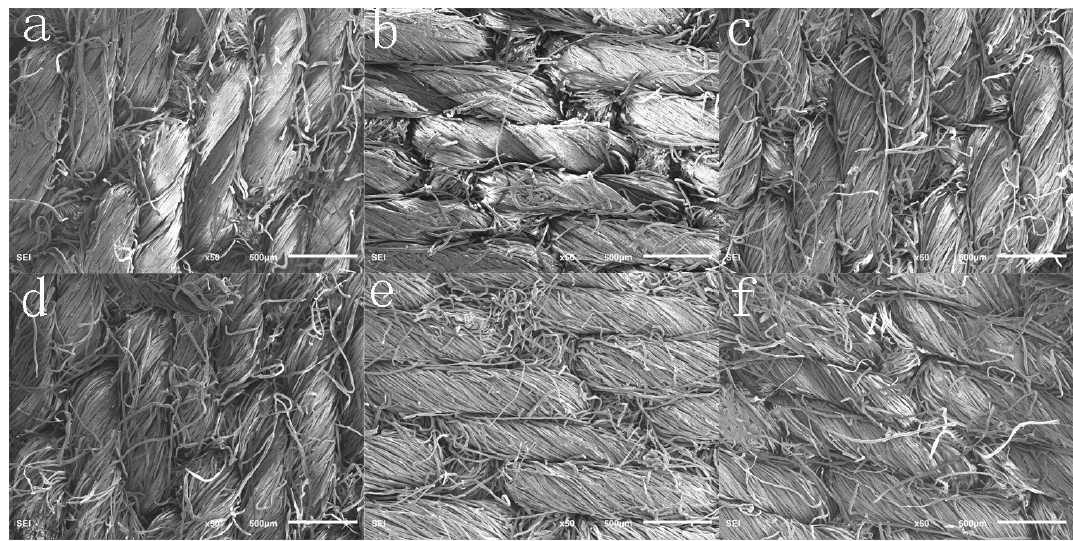
Figure 4. SEM pictures of different kapok/cotton samples (×50): a Desized, b laser bleaching, c Figure 5. SEM pictures of di ff erent kapok / cotton samples ( × 50): ( a ) Desized, ( b ) laser bleaching, ( c ) enzyme bleaching, d NaClO bleaching, e KMnO 4 bleaching, f H 2 O 2 bleaching. enzyme bleaching, ( d ) NaClO bleaching, ( e ) KMnO 4 bleaching, ( f ) H 2 O 2 bleaching.